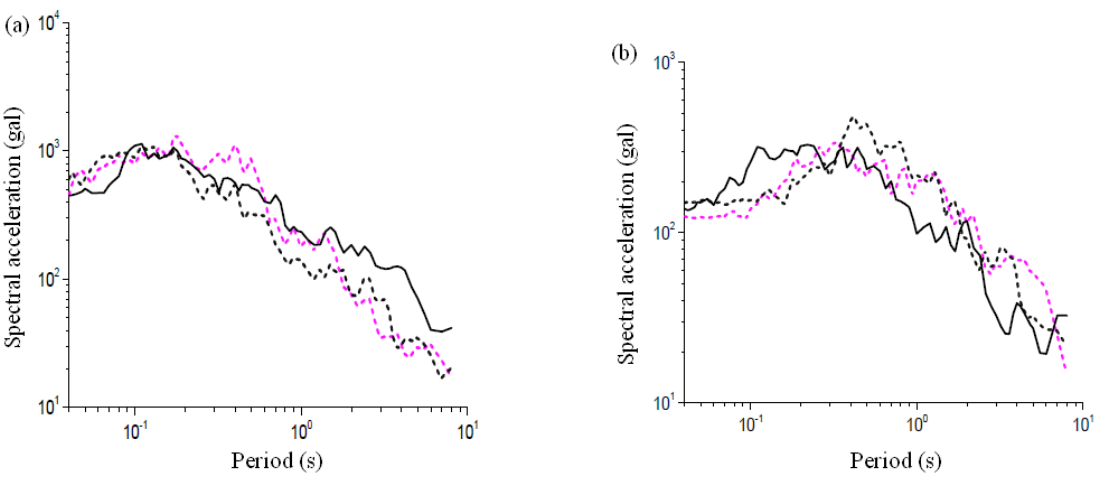
Figure 11. The mean acceleration response spectra of synthesized and observed motions at (a) Maoxian station (51MXT) and (b) Pixian station (51PXZ), redrawn from Tao et al.